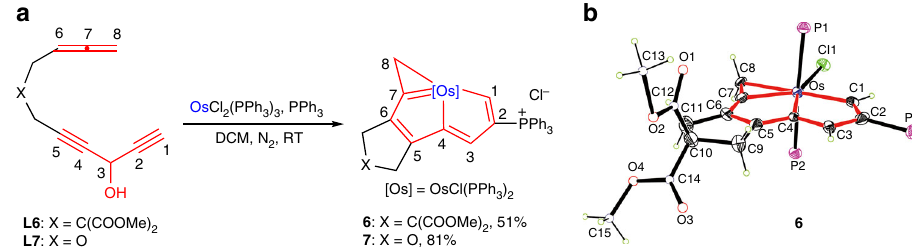
Fig. 4 Synthesis of CCCC-type chelates from allene group substituted diynes. a Allene group substituted diynes as ligand precursors to access CCCC-type chelates. b X-ray structure of the cation of 6 drawn with 50% probability (phenyl groups in PPh 3 are omitted for clarity). Selected bond distances (Å) and bond angles (deg): Os – C1 2.017(7), Os – C4 2.074(7), Os – C7 2.015(8), Os – C8 2.270(7), C1 – C2 1.383(11), C2 – C3 1.403(11), C3 – C4 1.381(10), C4 – C5 1.395